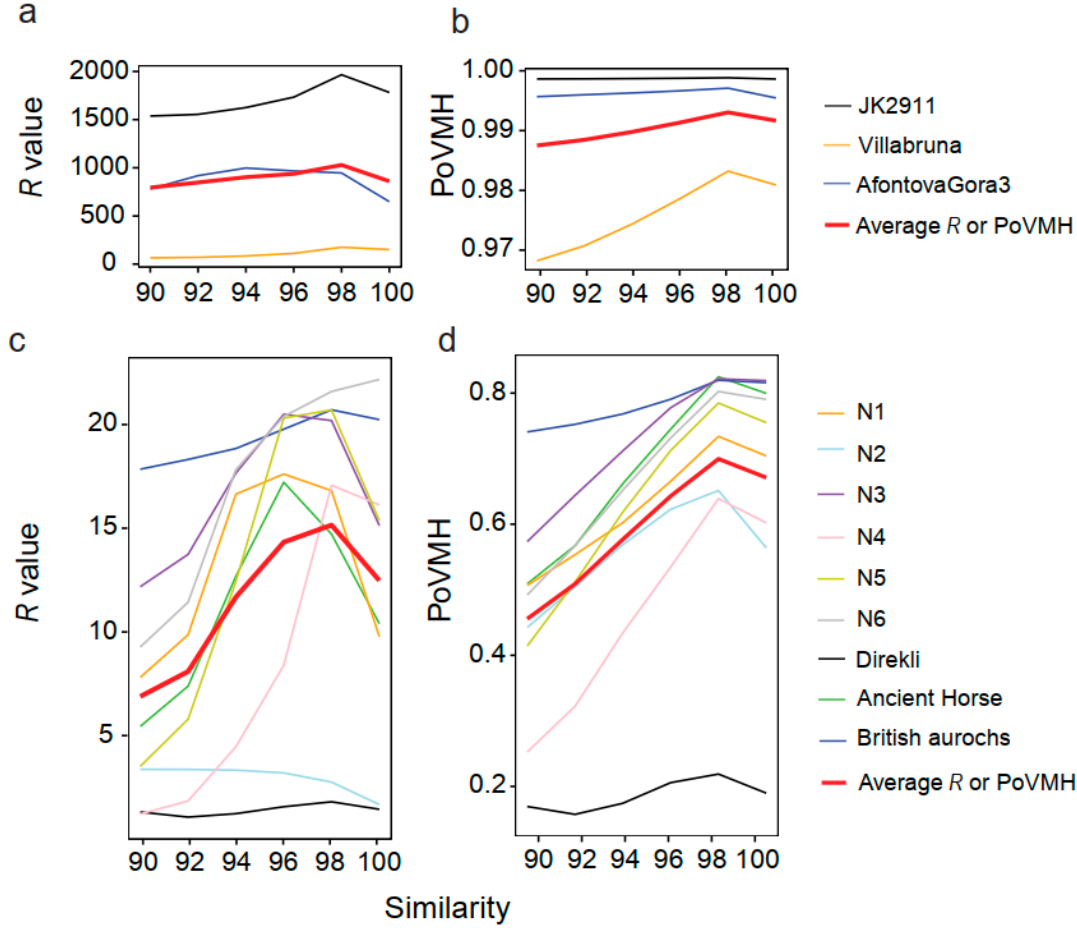
Figure 3. The R value and PoVMH of the top one species under different similarities based on the BLAST search